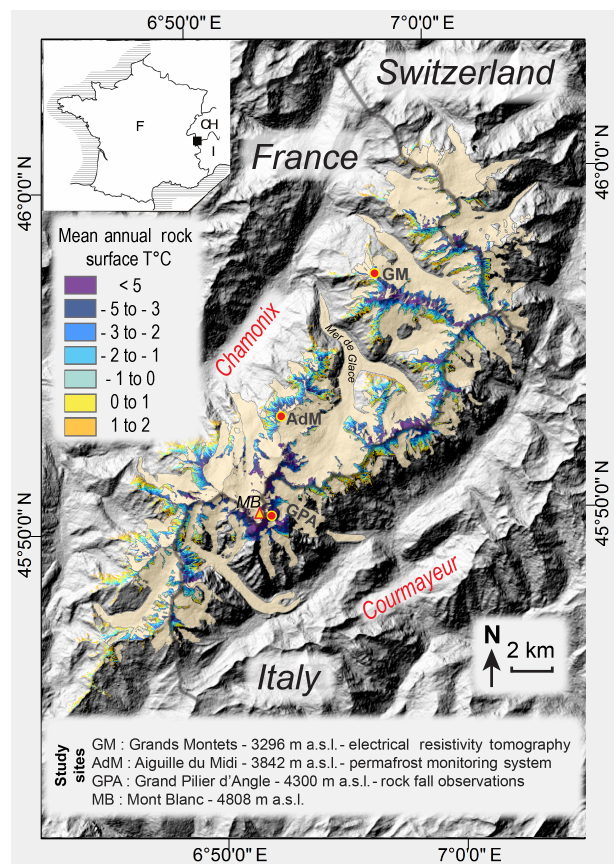
Figure 1. Location of the Mont Blanc massif, its glaciers and mean annual rock surface temperature (MARST). Areas with MARST < 0 ◦ C can be considered permanently frozen (Magnin et al., 2015a). Background topography: ASTER